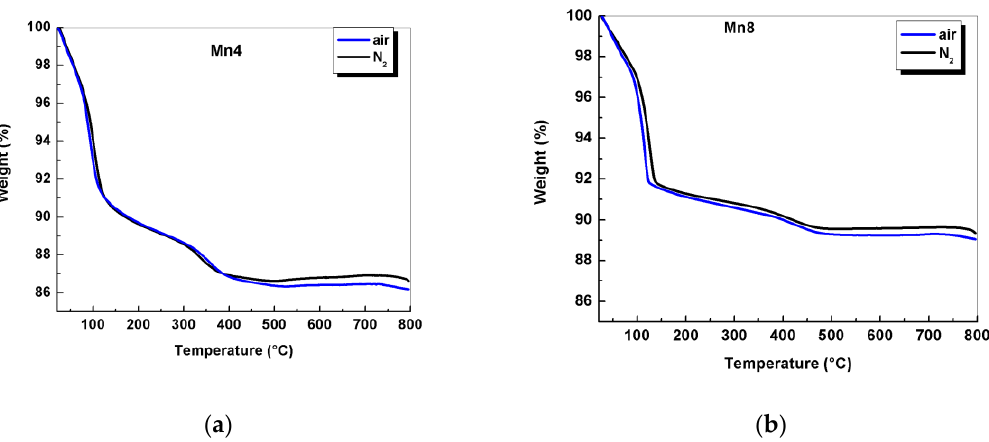
Figure 1. Thermograms in air and N 2 for synthesized birnessite-type materials. ( a ) birnessite type of material synthezised at 400°C, ( b ) birnessite type of material synthezised at 800°C.